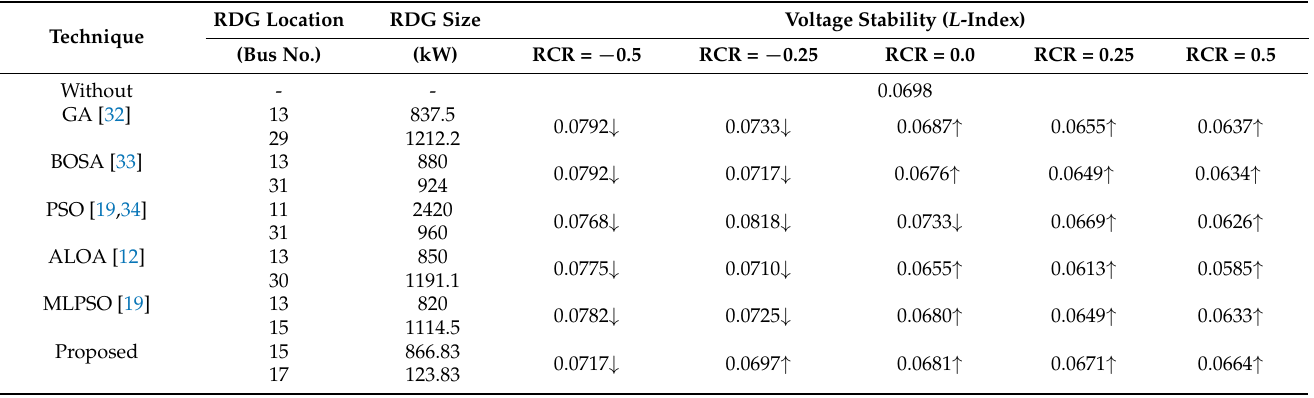
Table 11. Result for installing two RDGs of IEEE 33-bus distribution test system with three different RCR s ( ↑ : improvement of voltage stability; ↓ : degradation of voltage